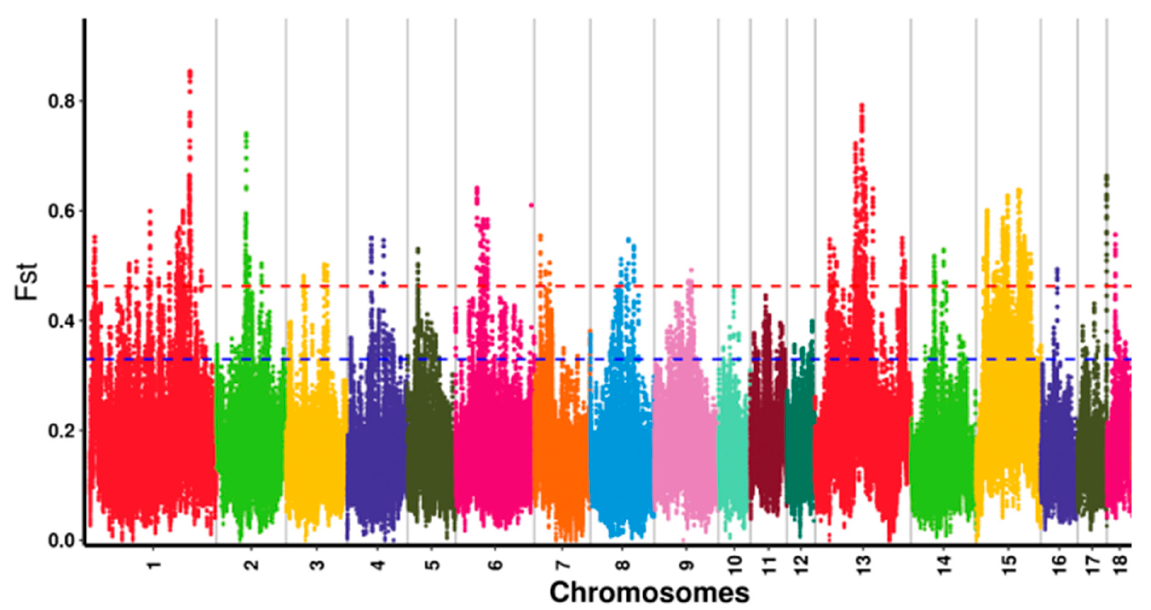
Figure 3. Distribution of F ST values among Anqing six-end-white pig autosomal chromosomes. Note: The red line represents the 0.01 level, and the blue line represents the 0.05 level. The different colors indicate that the SNPs are located on different chromosomes.